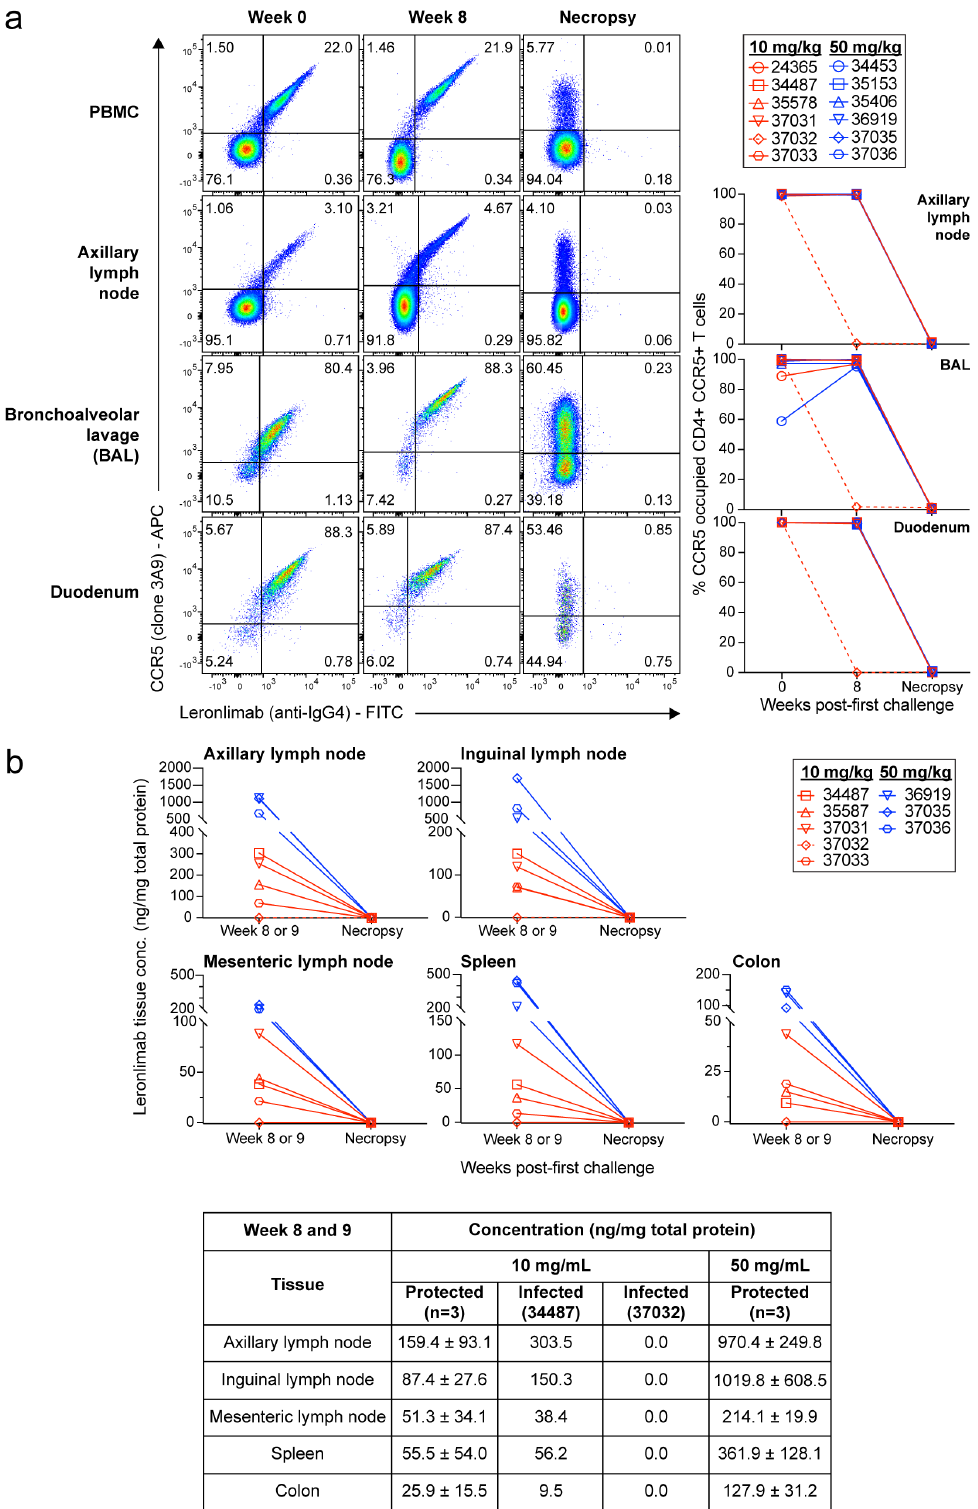
of occult SIV infection 33 , we longitudinally monitored for their emergence in all macaques. In line with longitudinal plasma and cell-associated viral load results (Figs. 2f and 4a, b), SHIV Gag- and Vif-speci fi c CD8 + T cells responses developed in all viremic ani- mals while it was absent in all aviremic animals, despite the pre- sence of CMV-speci fi c CD8 + T cells in all macaques (Fig. 4c and